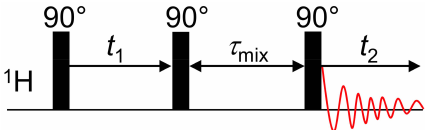
Figure 5. Schematic representation of the pulse sequence of the 2D Nuclear Overhauser SpectroscopY (NOESY)